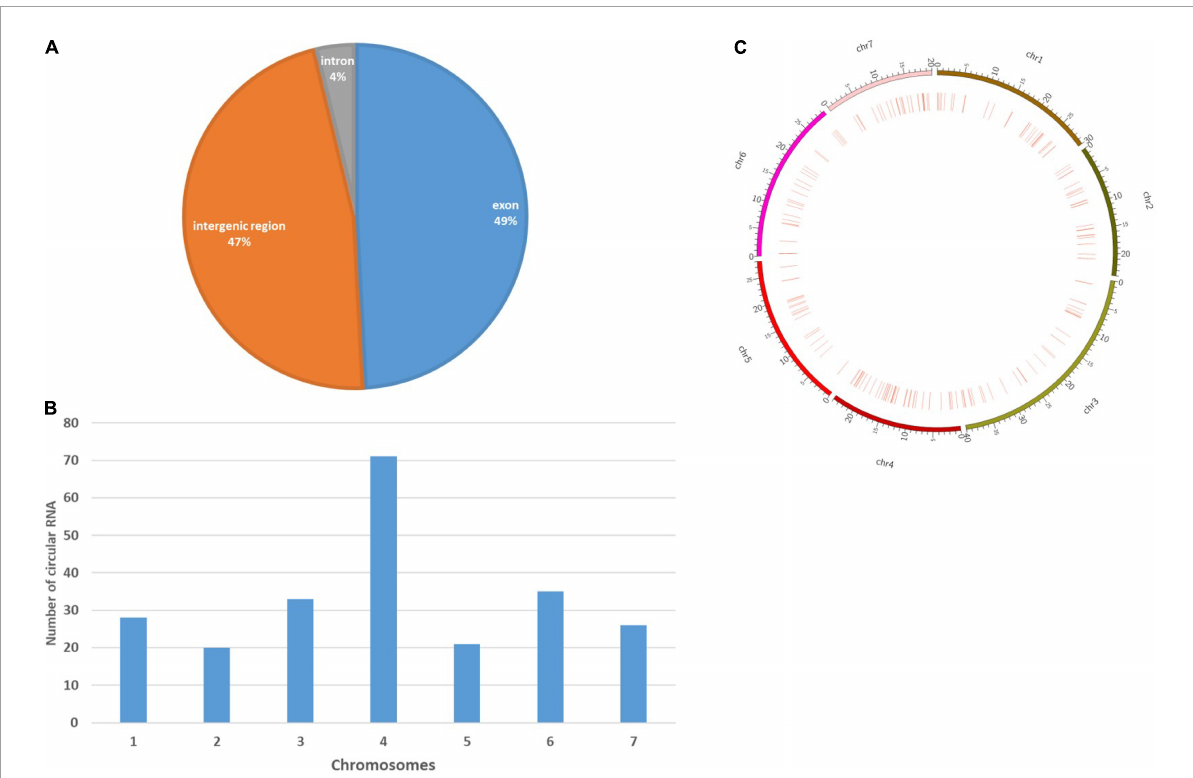
FIGURE6 Characterization of cucumber circRNAs. (A) Pie chart representing the amount and percentage of circular RNAs generated from exonic, intronic, and intergenic regions. (B) Circosplot showing the distribution of circular RNAs in seven cucumber chromosomes. (C) Histogram showing the number of circRNAs detected in seven cucumber